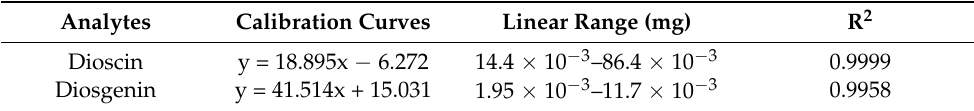
Table 3. Calibration curves of dioscin and diosgenin using HPLC ( n = 6).